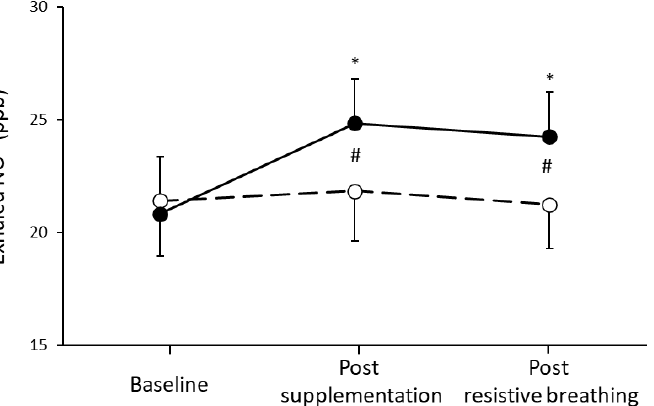
Figure 1. Exhaled NO • at baseline, one hour post L-citrulline (closed circles) and placebo (open circles) supplementation and post resistive breathing to task failure. (*) indicates significant difference ( p < 0.05) compared to baseline; (#) indicates significant difference ( p < 0.05) between the L-citrulline and placebo conditions.